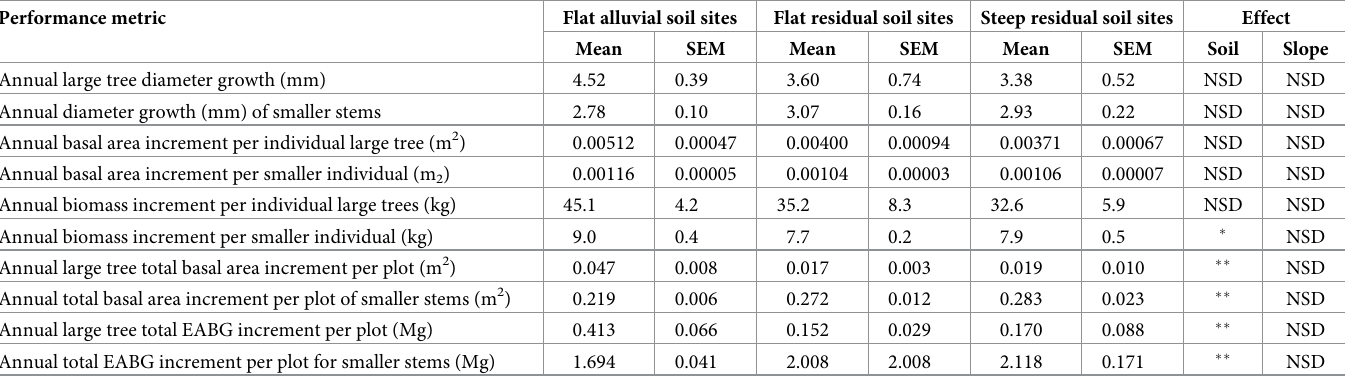
Table 6. Stem growth across edaphic categories.